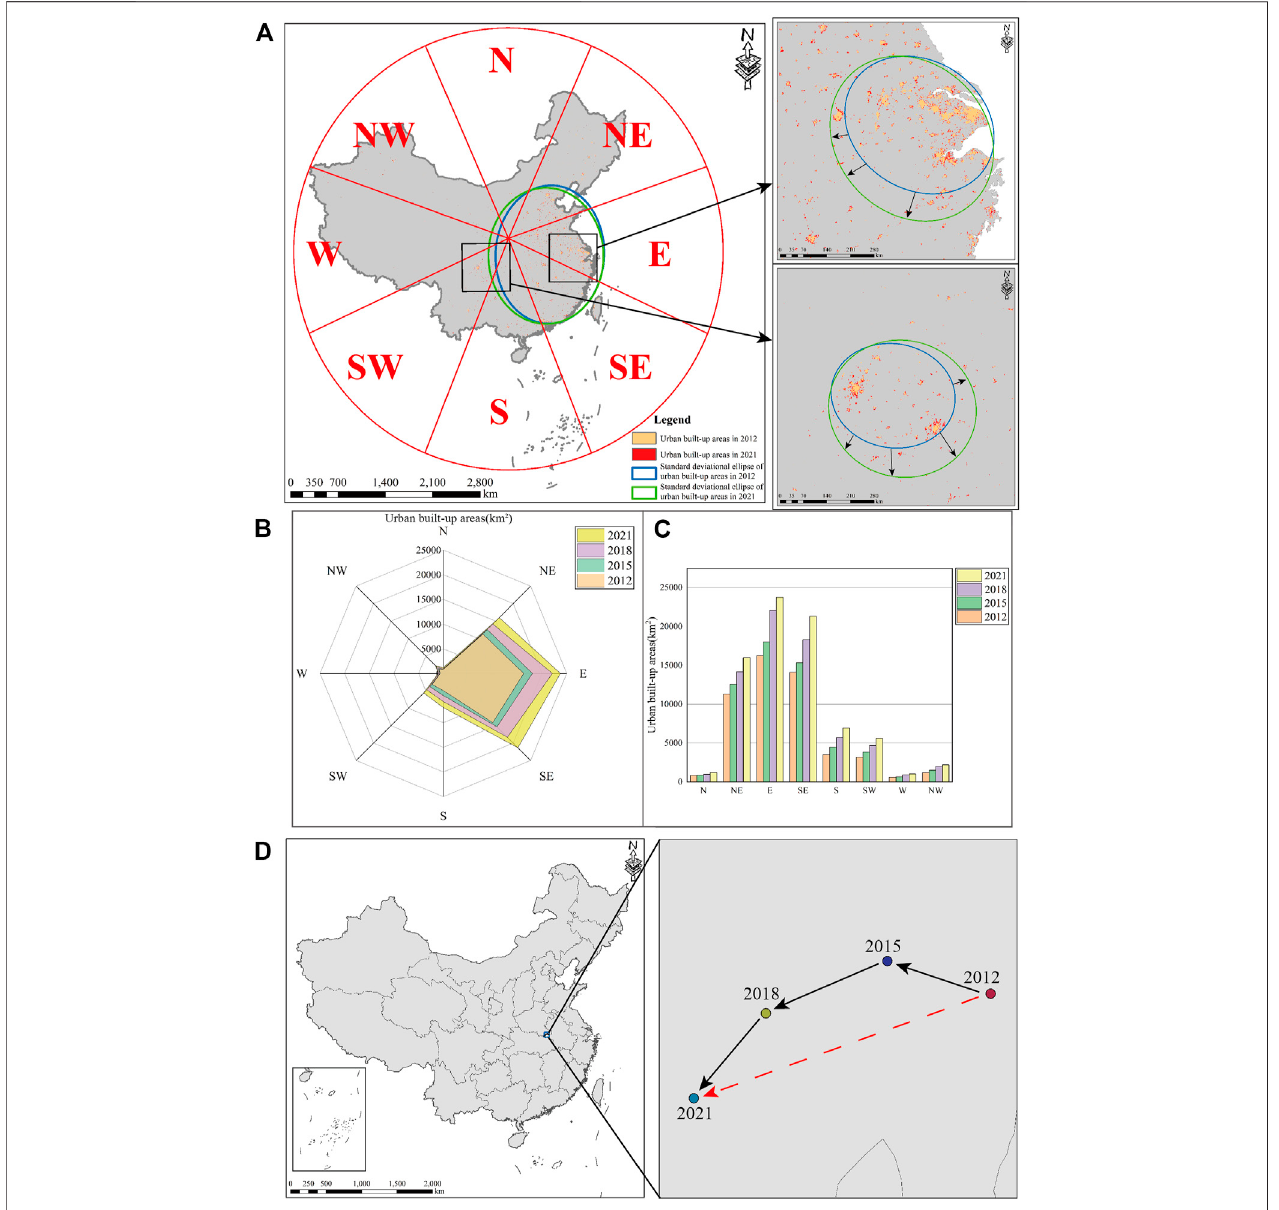
FIGURE8|(A – C) Expansionofurbanbuilt-upareasinallorientationsfrom2012to2021. (D) GravitycentermigrationofChina ’ surbanbuilt-upareas,2012 – 2021.